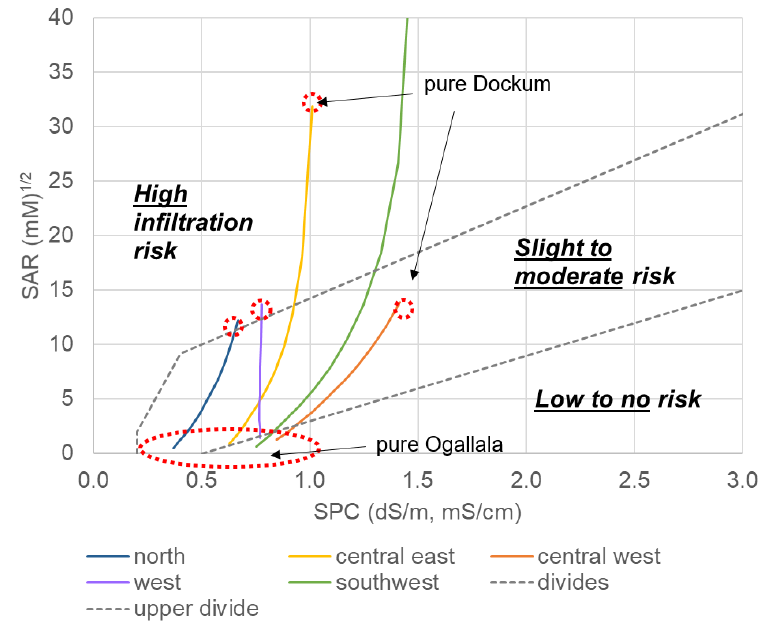
Figure 14. Sodicity risk examination across all regions in the study area. The southwest region line continues up to a maximum SAR of 53.3 mM 1/2 . The figure truncated in the vertical for ease of